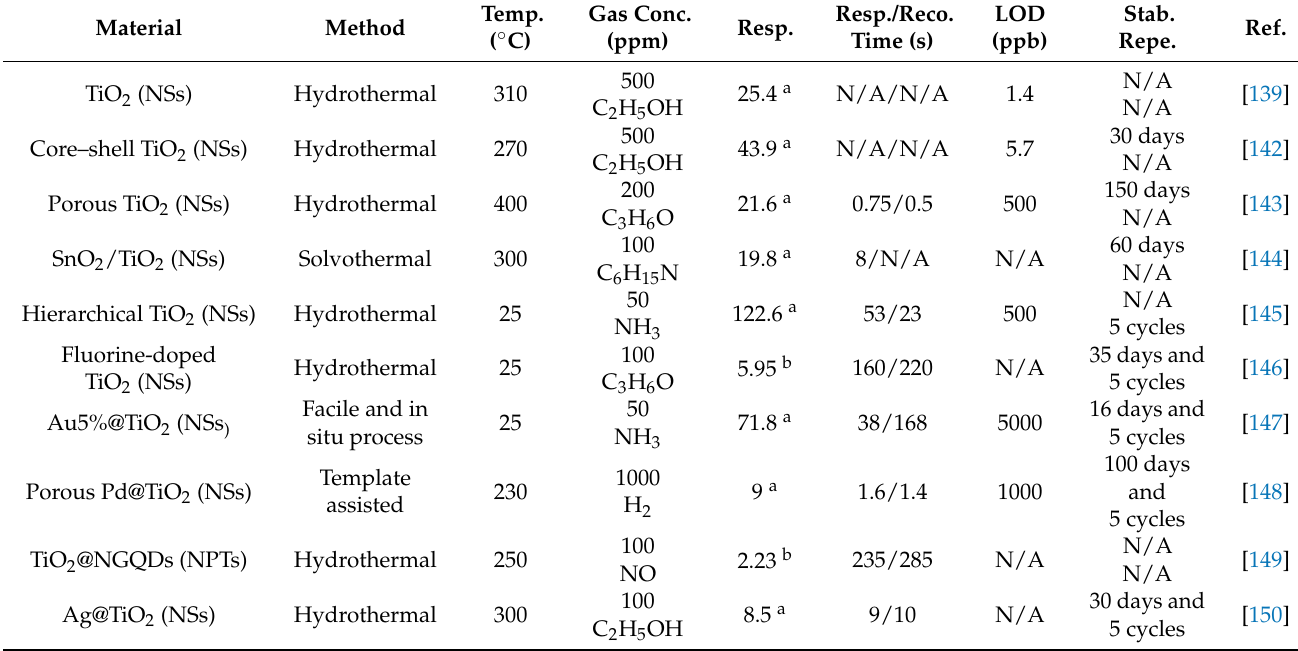
Table 6. Gas-sensing functionality of 2D TiO 2